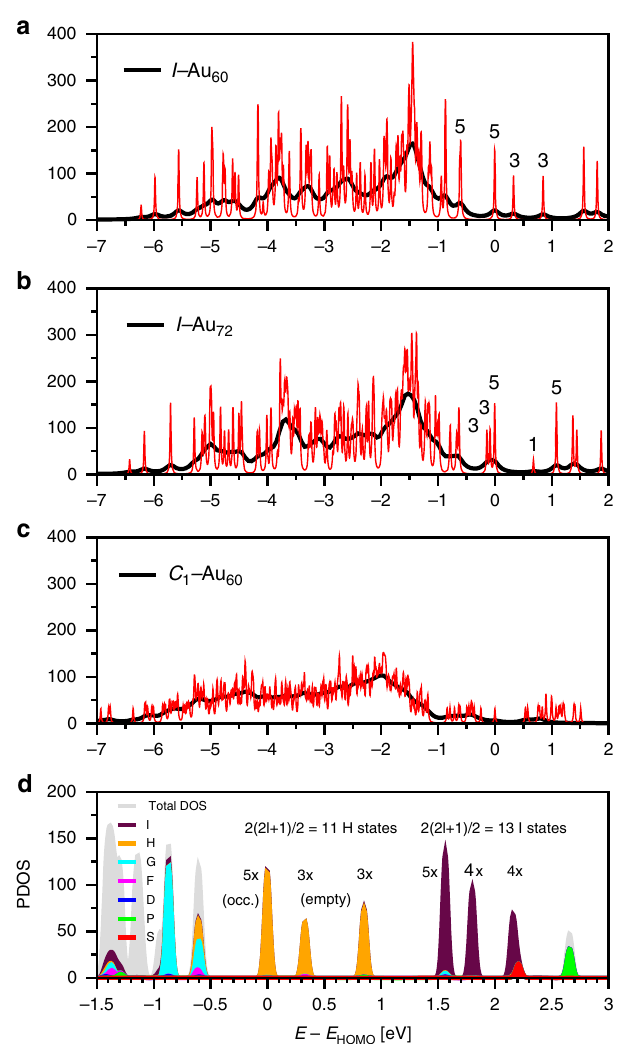
Fig. 3 Electronic-structure comparison of I − Au 60 , I h − Au 60 , and C 1 − Au 60 clusters. a – c Electronic density of states (eDOS) of I − Au 60 , I − Au 72 , and C − Au 1 60 clusters. Degeneracies are indicated by the numbers. To highlight